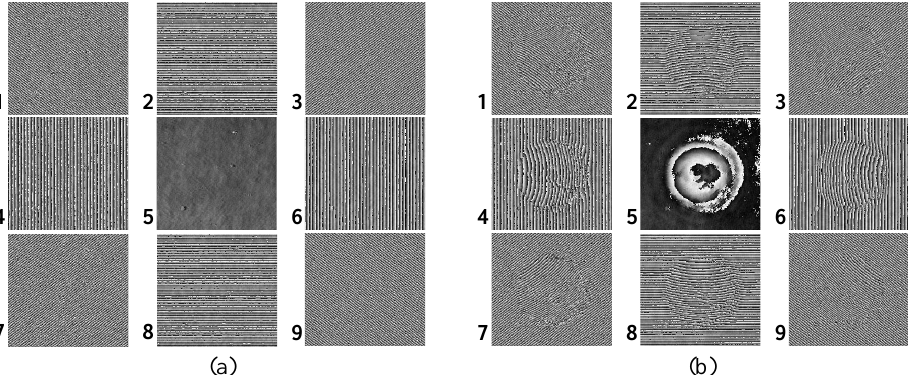
Figure 5. Phase information of ( a ) reference and ( b ) object holograms is obtained by inverse Fourier transform of each windowed